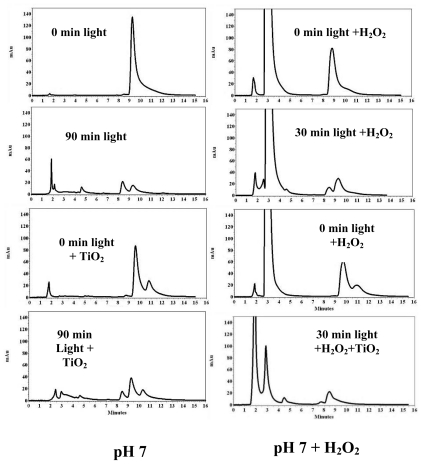
HPLC chromatograms of 2,2′,4,4′-tetrachlorobiphenyl (9.4 ± 0.2 min) irradiated in the presence of TiO2 and/or H2O2 at pH 7.